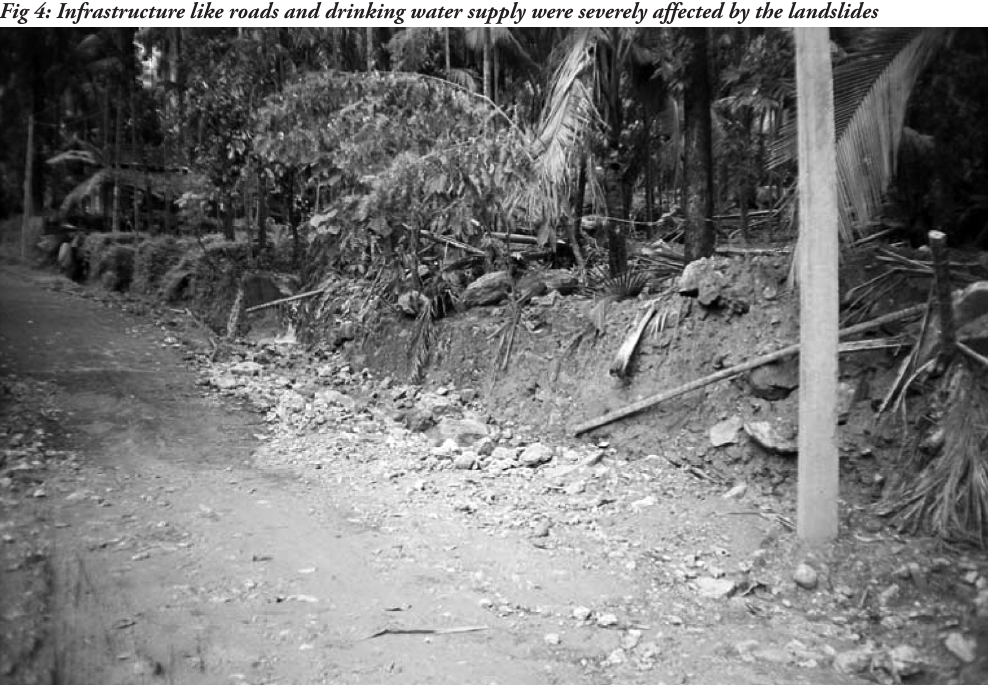
Source: Photos taken during the fieldwork by Sunil D